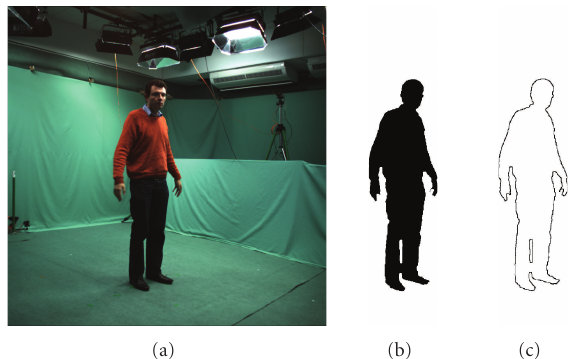
Figure 2: The di ff erent steps of the image processing: (a) image acquisition, (b) background subtraction (binary image), and (c) exact silhouette polygon (250 vertices).